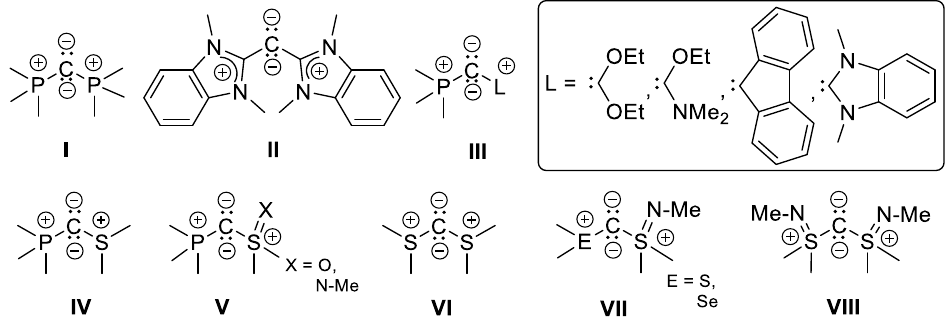
Figure 1. Carbodiphosphoranes I , carbodicarbenes II , carbophosphinocarbenes III , phosphonio/sulfonio bis-ylides IV , phosphonio/sulfoxonio or phosphonio/iminosulfonio bis-ylides V , sulfonio/sulfonio bis-ylides VI , selenio- or sulfonio-/iminosulfonio VII, and bis iminosulfanebis-ylides VIII .